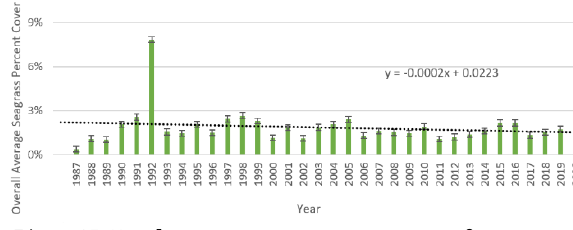
Figure 15. Yearly average seagrass percent cover from spectral